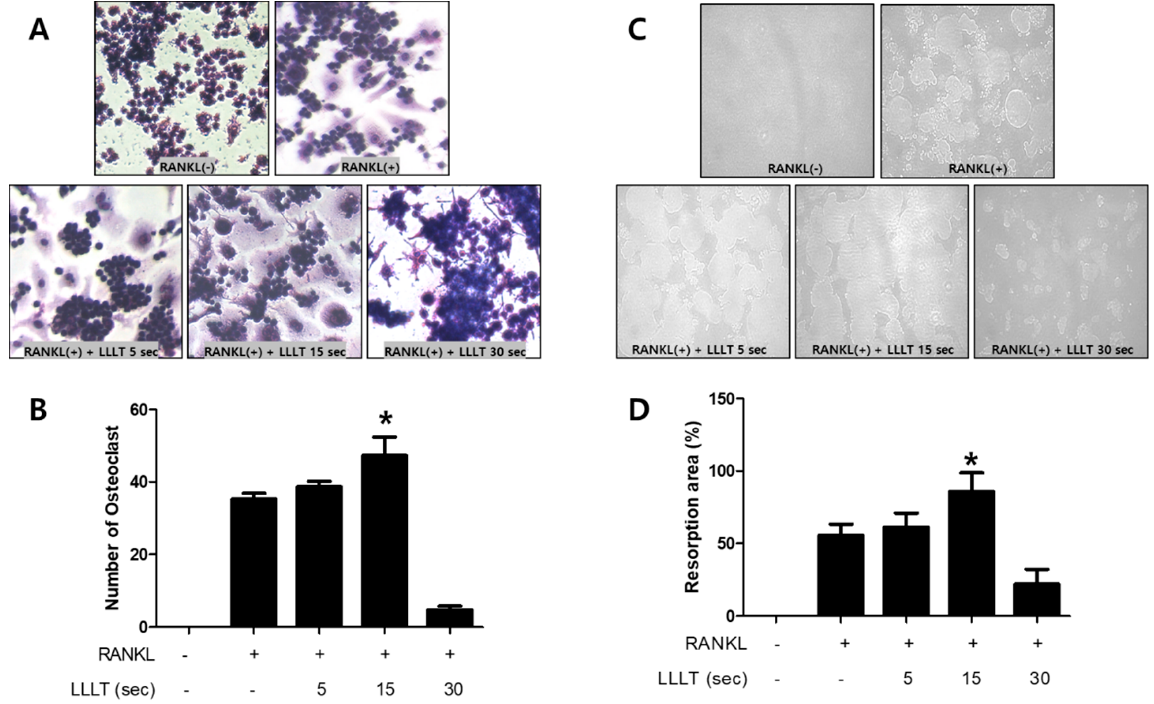
Figure 2. Effects of LLLT on RANKL-induced osteoclastogenesis and pit formation. ( A ) RAW 264.7 cells were cultured with RANKL (10 ng/mL) for 5 days to induce osteoclast differentiation with treatment with LLLT (5–30 s) to assess its osteoclastogenic effect. ( B ) The number of TRAP-positive multinucleated cells was counted. * p < 0.05 compared with RANKL alone. ( C ) Resorption pit formation were observed on Corning ® Osteo Assay Surface, and ( D ) the pit area was calculated as the absorbed area/total area. * p < 0.05 compared with RANKL alone.